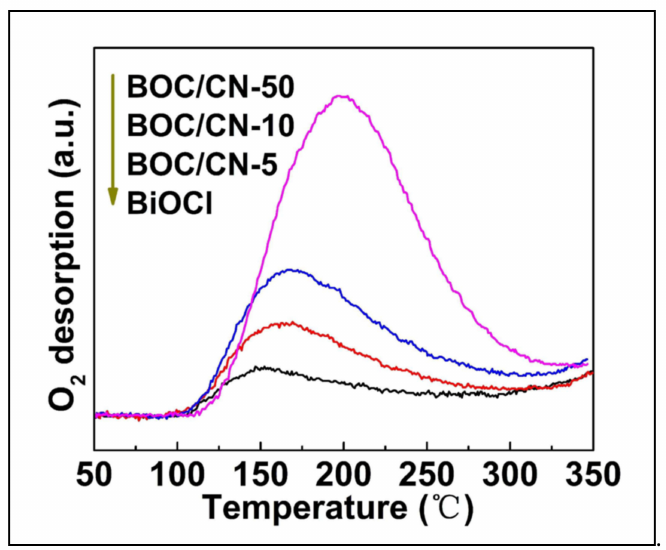
Figure 9. The O 2 -TPD profiles of BiOCl, BOC/CN-5, BOC/CN-10, and BOC/CN-50. Reproduced with permission from Hou W et al, ChemistrySelect; published by John Wiley and Sons,